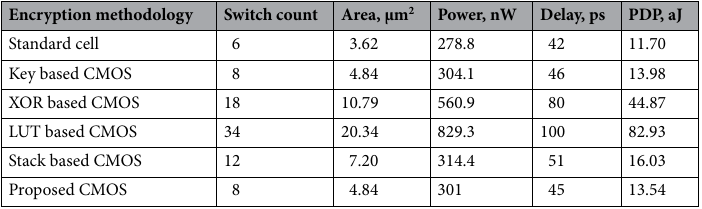
Table 12. Results cmparison for OR gate.